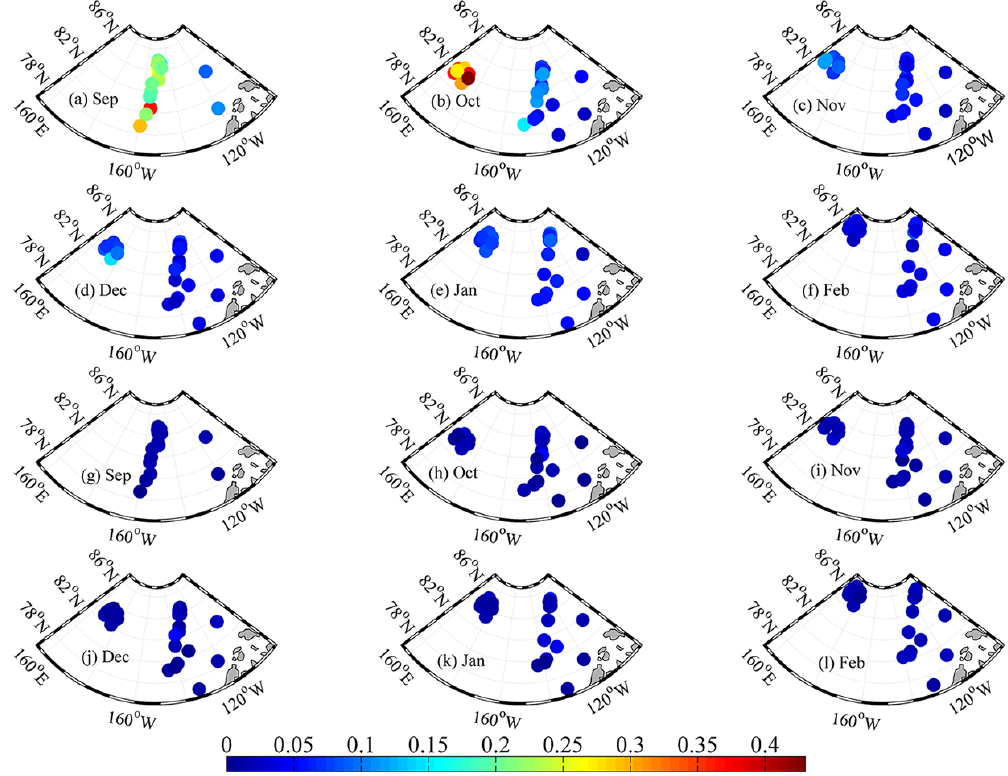
Figure 9. Amplitudes after Fourier transformation of monthly time series of normalized ice velocity at the negative-phase inertial fre- quency (a–f) and positive-phase semidiurnal frequency (g–l) from September 2018 to February